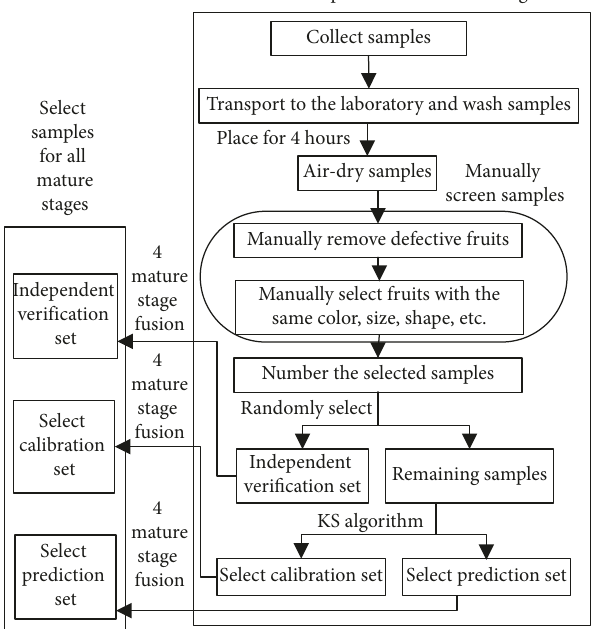
Figure 1: Workflow showing the selection of the